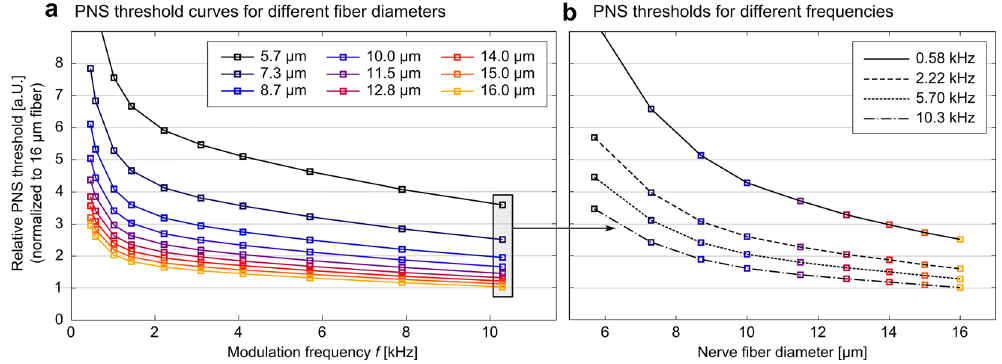
Figure 7. ( a) PNS thresholds as a function of the frequency of the applied coil current (sinusoidal current) for different fiber diameters. The largest fibers show the lowest threshold (i.e., they are easiest to stimulate). ( b) PNS thresholds as a function of fiber diameter, while keeping the frequency